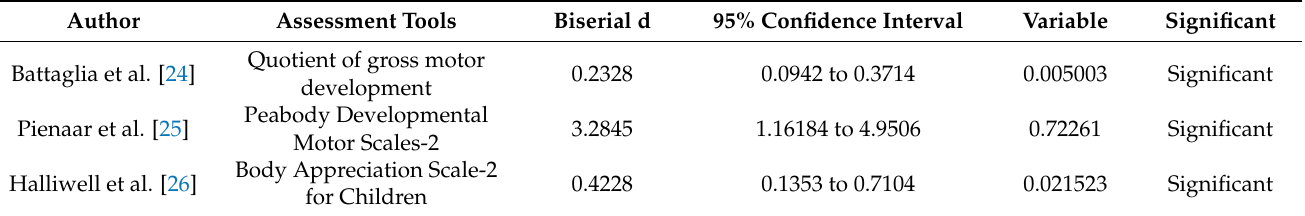
Table 4. Effectiveness of interventions related to body